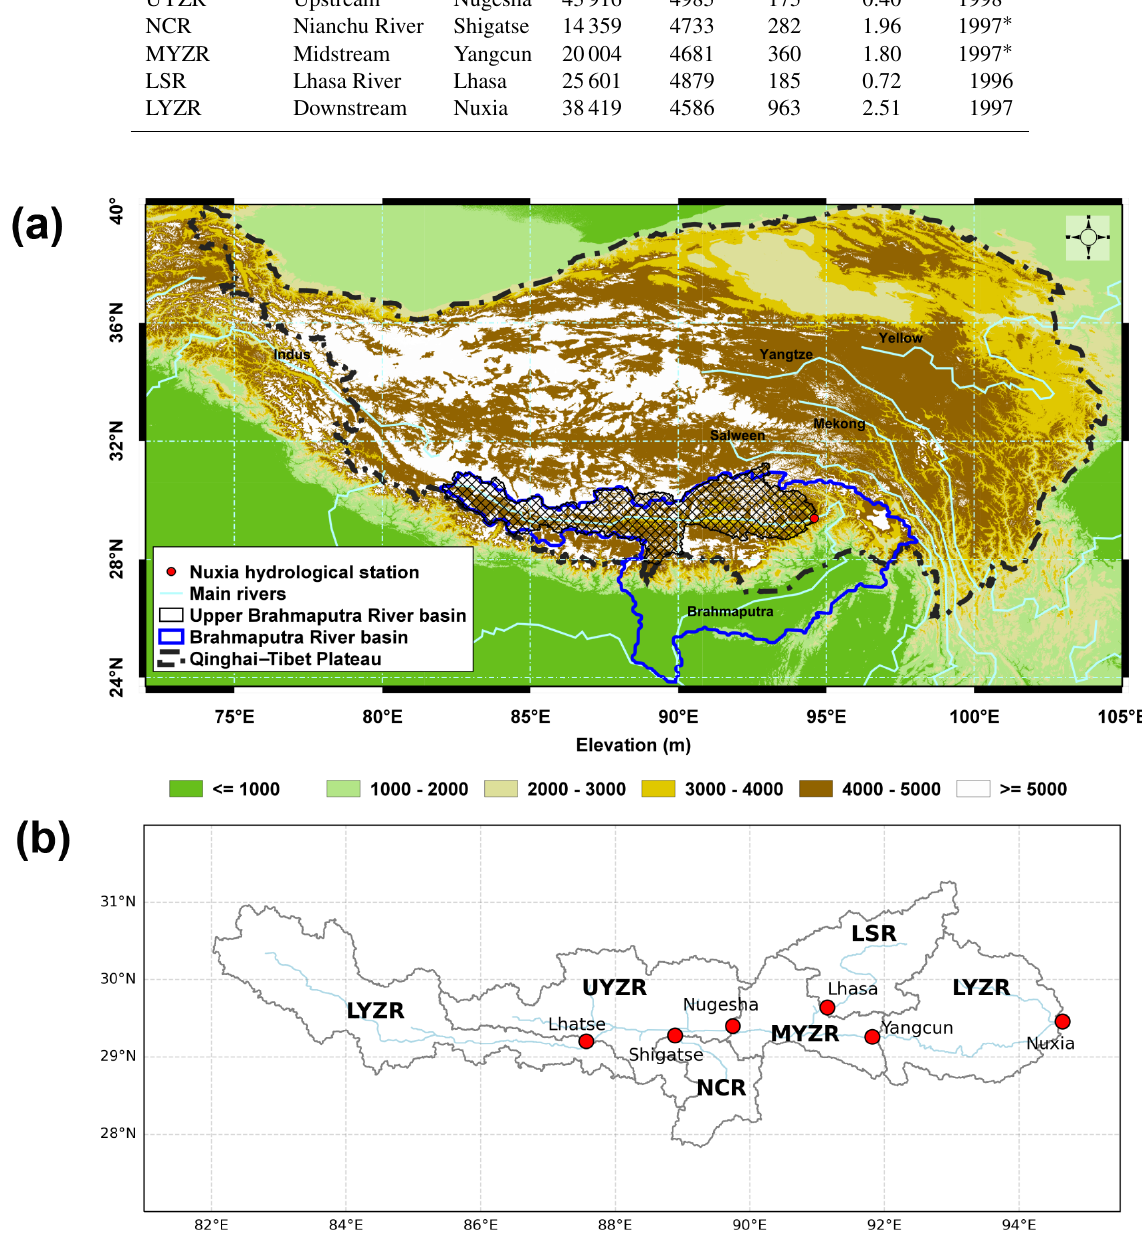
Figure 1. Location of (a) the Upper Brahmaputra River (UBR) basin in the Qinghai–Tibet Plateau (QTP), which is from Li et al. (2021), and (b) six basins divided by the Lhatse, Nugesha, Shigatse, Yangcun, Lhasa, and Nuxia hydrological